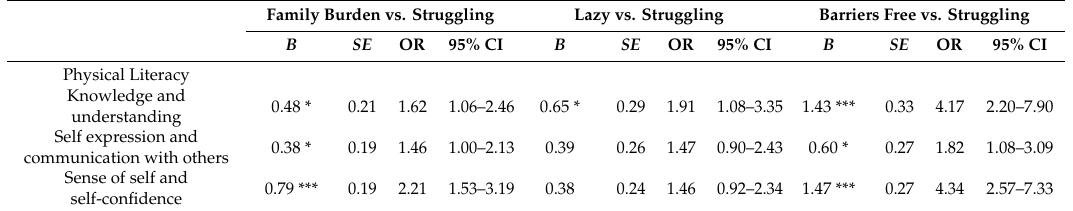
Table 4. Multinomial logistic regression on group membership by domains of physical literacy. Family Burden vs. Struggling Lazy vs. Struggling Barriers Free vs. Struggling